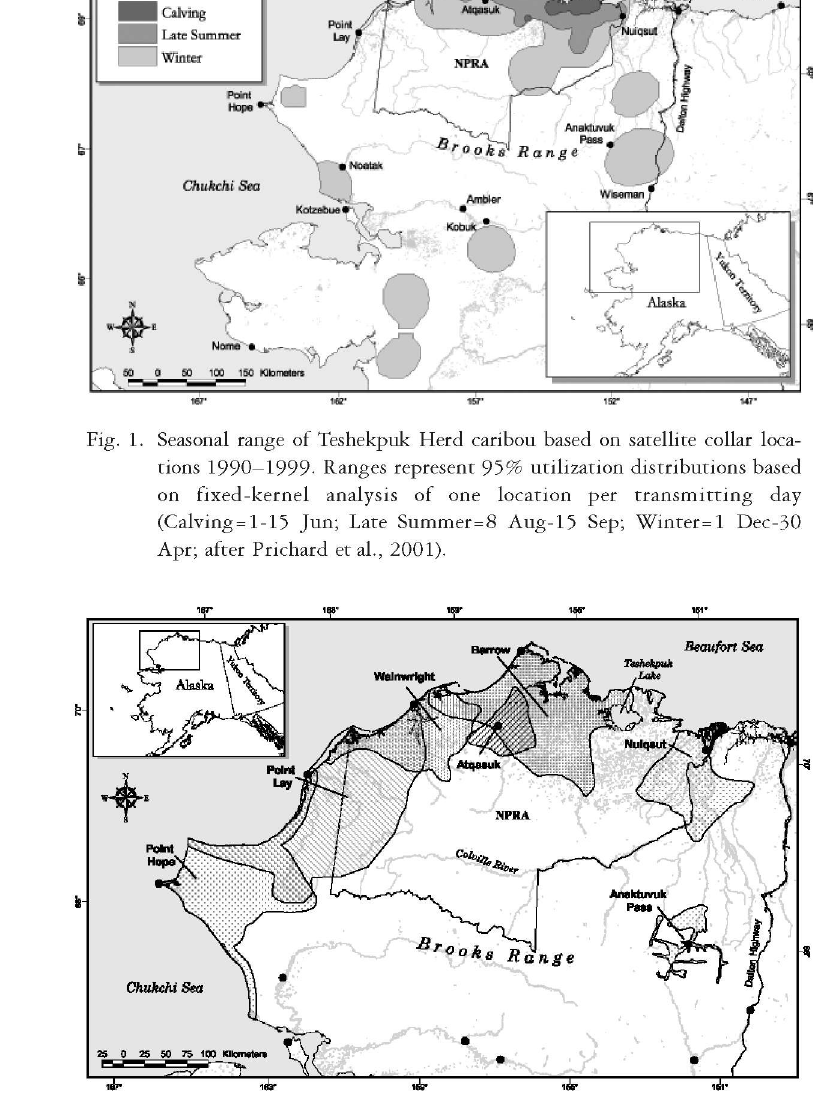
Fig. 2. Approximate subsistence hunting areas for seven villages within the range of Teshekpuk Herd